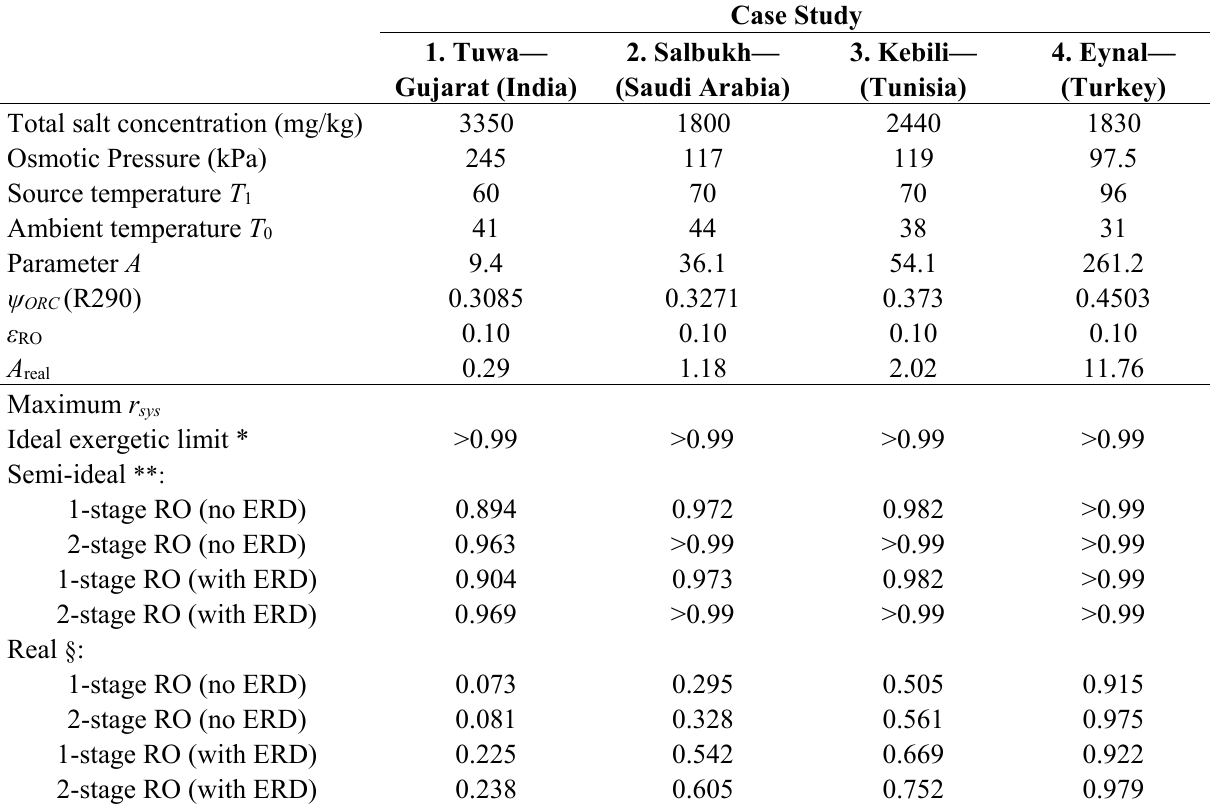
Table 4. Calculated values of system recovery r sys using the organic Rankine cycle and reverse osmosis under ideal, semi-ideal and real